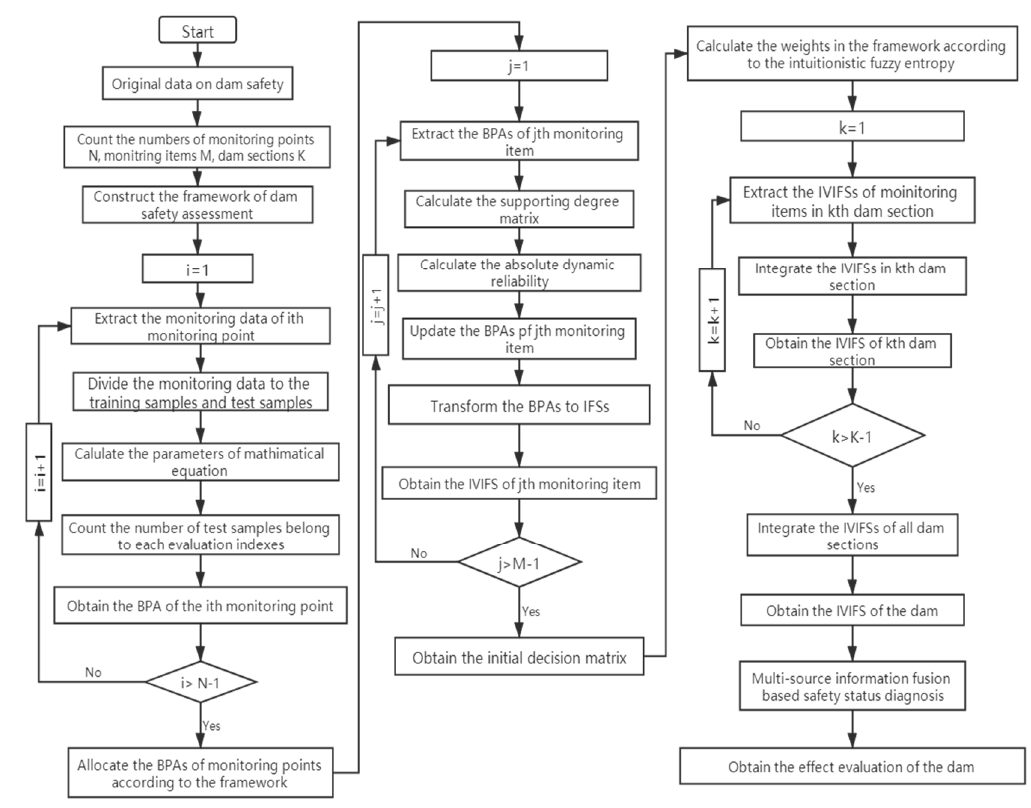
Figure 5. The algorithm flowchart of the dam safety assessment model.